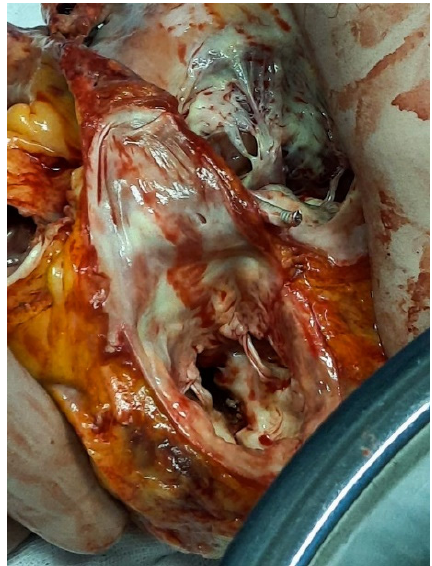
Figure 2. Explanted heart with massive calcification.